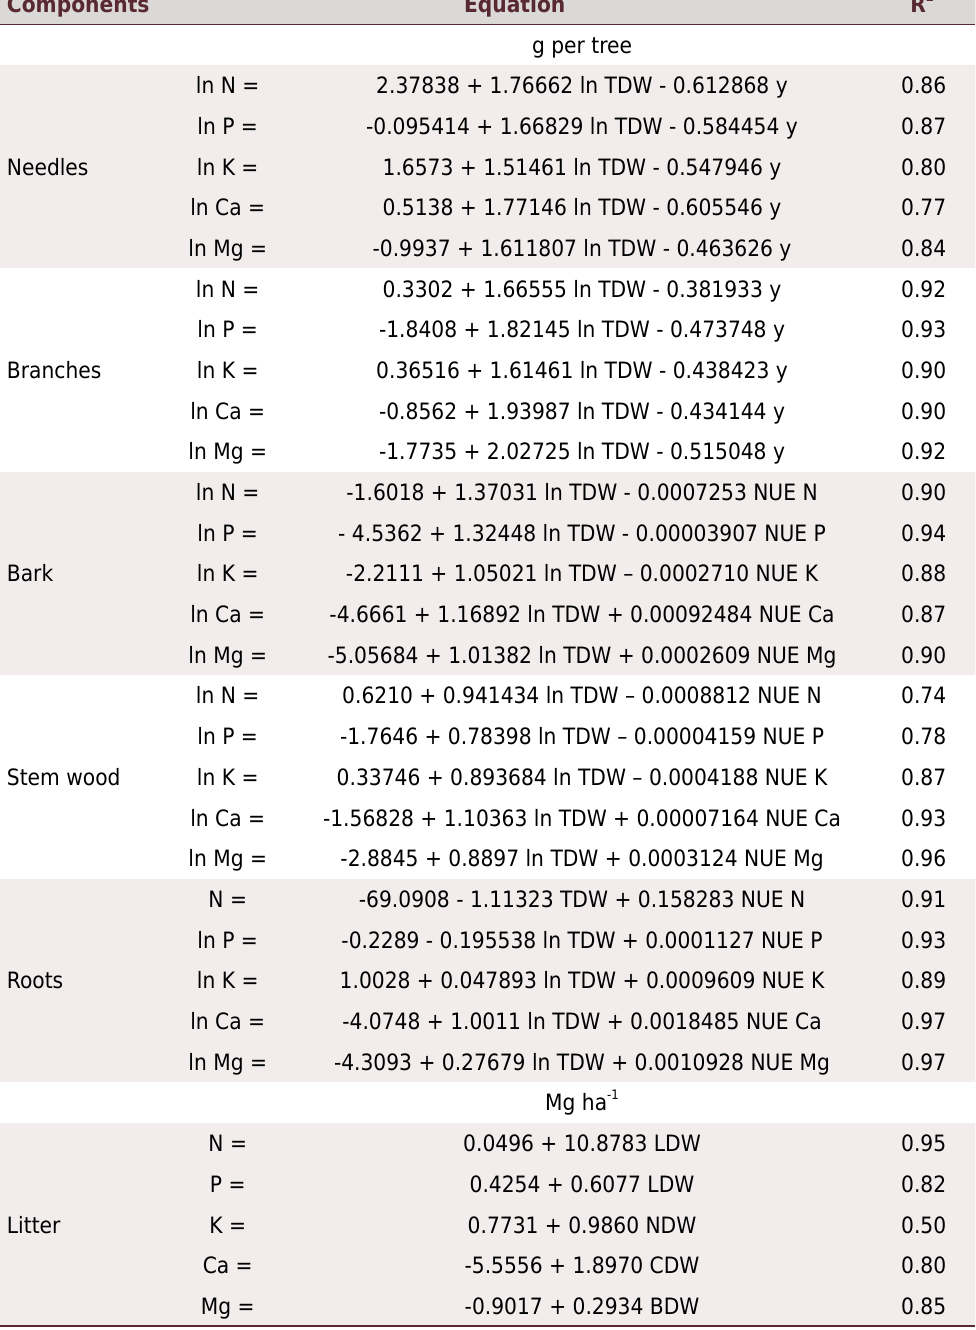
Table 7. Equations to estimate nutrient accumulation in Pinus taeda stands in Southern Brazil Components Equation R 2 g per tree